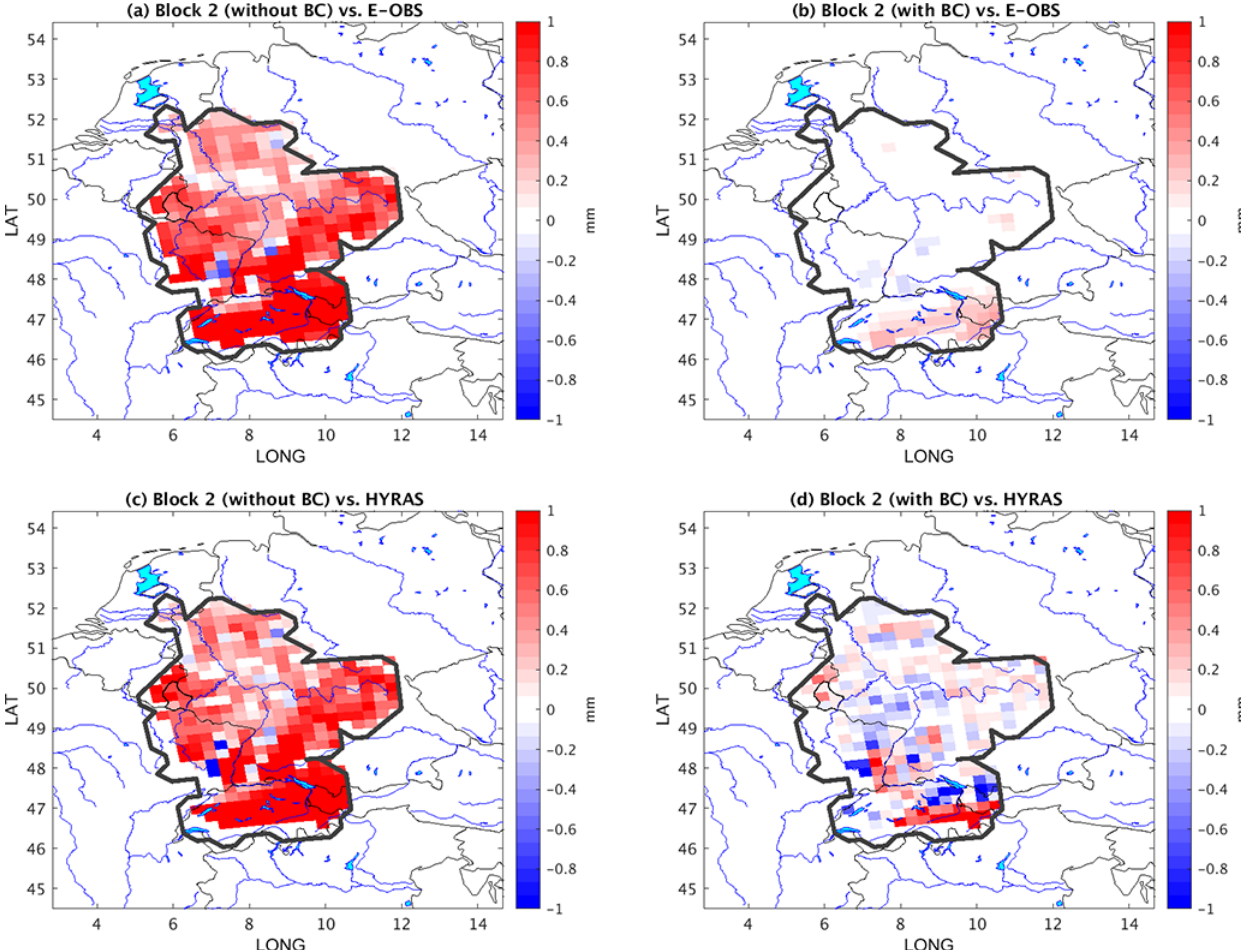
Figure 2. Bias within the Rhine basin (bold black contour) of daily precipitation [in mm] for the LAERTES-EU ensemble mean based on data block 2 (a) towards E-OBS uncorrected, (b) towards E-OBS after bias correction, (c) towards HYRAS uncorrected, and (d) towards HYRAS after bias correction. Thin black lines show country borders; blue lines indicate rivers; cyan-shaded areas show lakes.